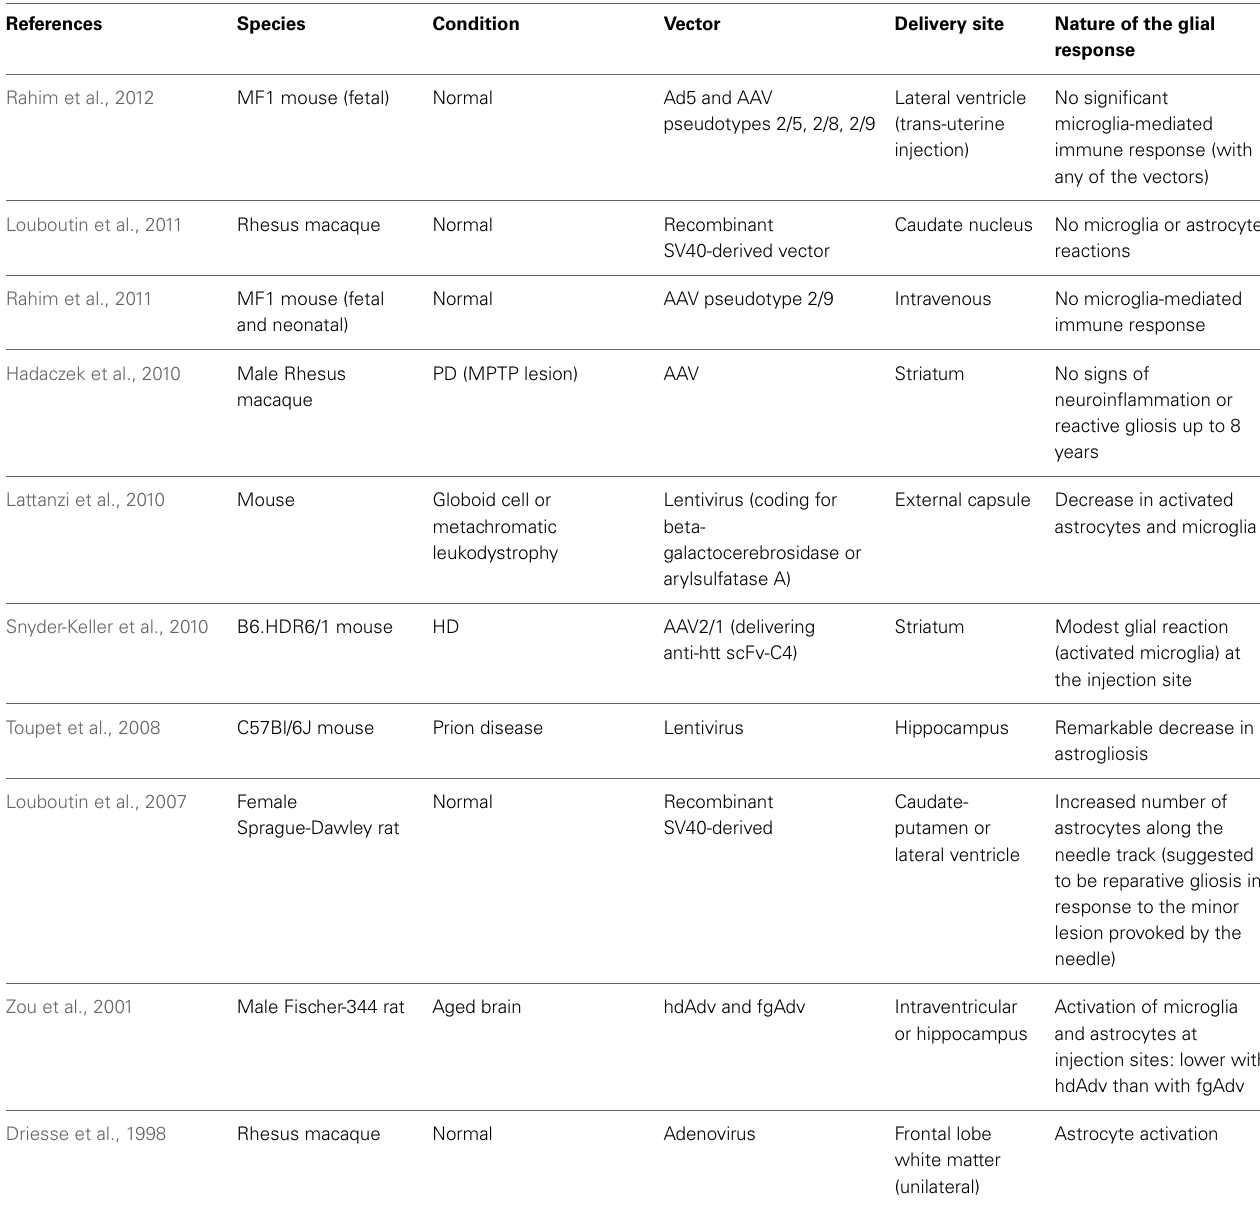
Table 2 | Glial response to neurotrophic therapies in in vivo